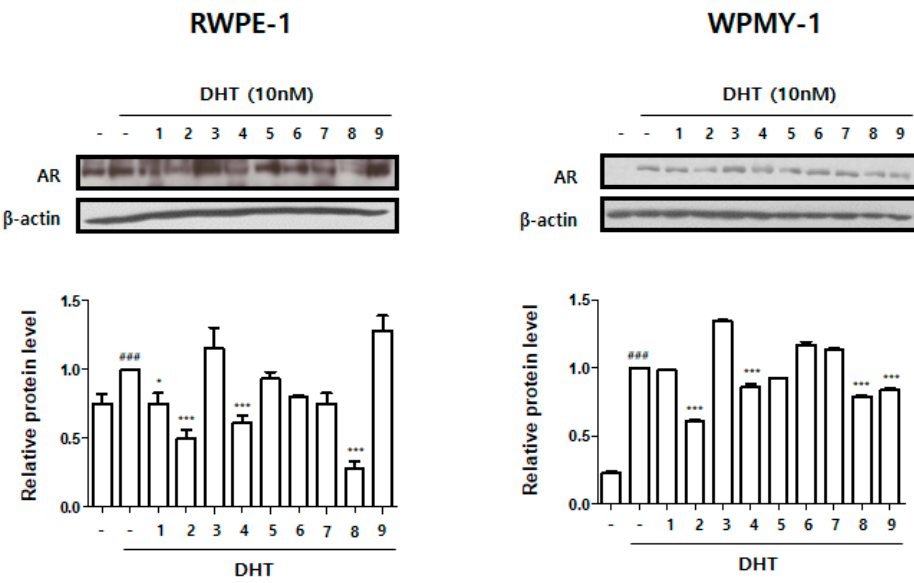
Figure 3. E ff ect of nine herbs of HBX-5 on the AR expression in human normal prostate cell. The normal human prostatic epithelial cell line, RWPE-1 and normal human prostatic stromal cell line, WPMY-1 were treated with 10 nM DHT for 72h and 24hr respectively, with or without each herb of HBX-6. 1, Aconitum carmichaelii 250 µ g / mL; 2, Cornus o ffi cinalis Sieb. et Zucc. 250 µ g / mL; 3, Cistanche deserticola Y. C. Ma 250 µ g / mL; 4, Psoralea corylifolia L. 250 µ g / mL; 5, Dendrobium loddigesii Rolfe. 250 µ g / mL; 6, Morinda o ffi cinalis How 250 µ g / mL; 7, Cuscuta chinensis Lam. 250 µ g / mL; 8, Trigonella foenum-graecum L. 250 µ g / mL; 9, Foeniculum vulgare Miller 2 µ g / mL; β -actin was used as a loading control. The protein band densities were obtained by densitometric analysis. Density values were presented as mean ± S.D. (### p < 0.001 versus untreated control group; * p < 0.05, ** p < 0.01, *** p < 0.001 versus DHT-stimulated group).